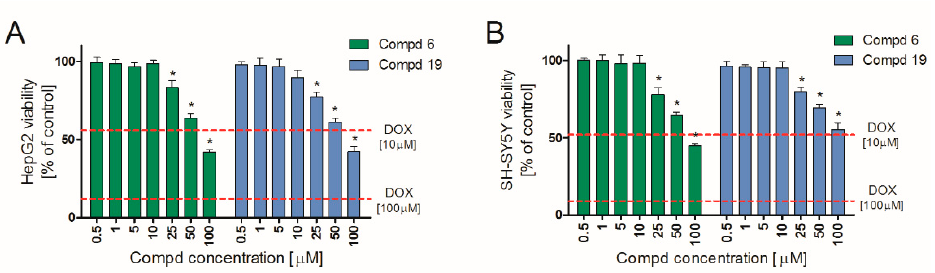
Figure 4. HepG2 ( A ) and SH-SY5Y ( B ) cell lines viability in the presence of 6 and 19 . Cells were cultured with tested compounds for 24 h and then MTT assay was performed. Each bar represents viability expressed as mean % of control (non-treated cells) ± SEM. The dashed lines indicate the toxicity of the positive control (doxorubicin, DOX). * Statistical significance versus control ( p < 0.05).